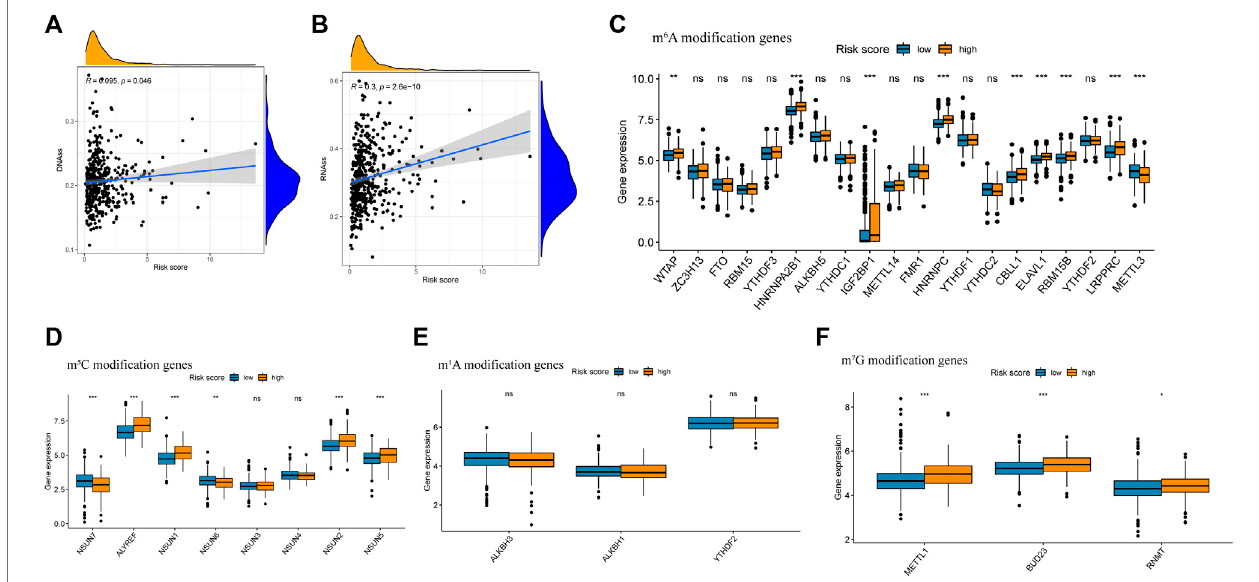
FIGURE 10 | Analysis of risk score with tumor stem cell score and Differential expression of m 6 A related gene between high risk score group and low risk score group. (A) The relationship between risk score and RNAss. (B) The relationship between risk score and DNAss. (C) Differential expression analysis of m 6 A related gene betweenhighriskscoregroupandlowriskscoregroup. (D) Differentialexpressionanalysisofm 5 Crelatedgenebetweenhighriskscoregroupandlowriskscoregroup. (E) Differential expression analysis of m 1 A related gene between high risk score group and low risk score group. (F) Differential expression analysis of m 7 G related gene between high risk score group and low risk score group.